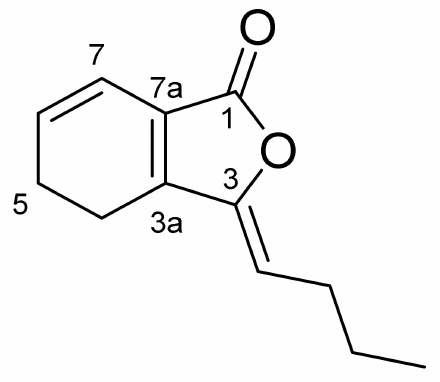
Figure 2. Structural formula of